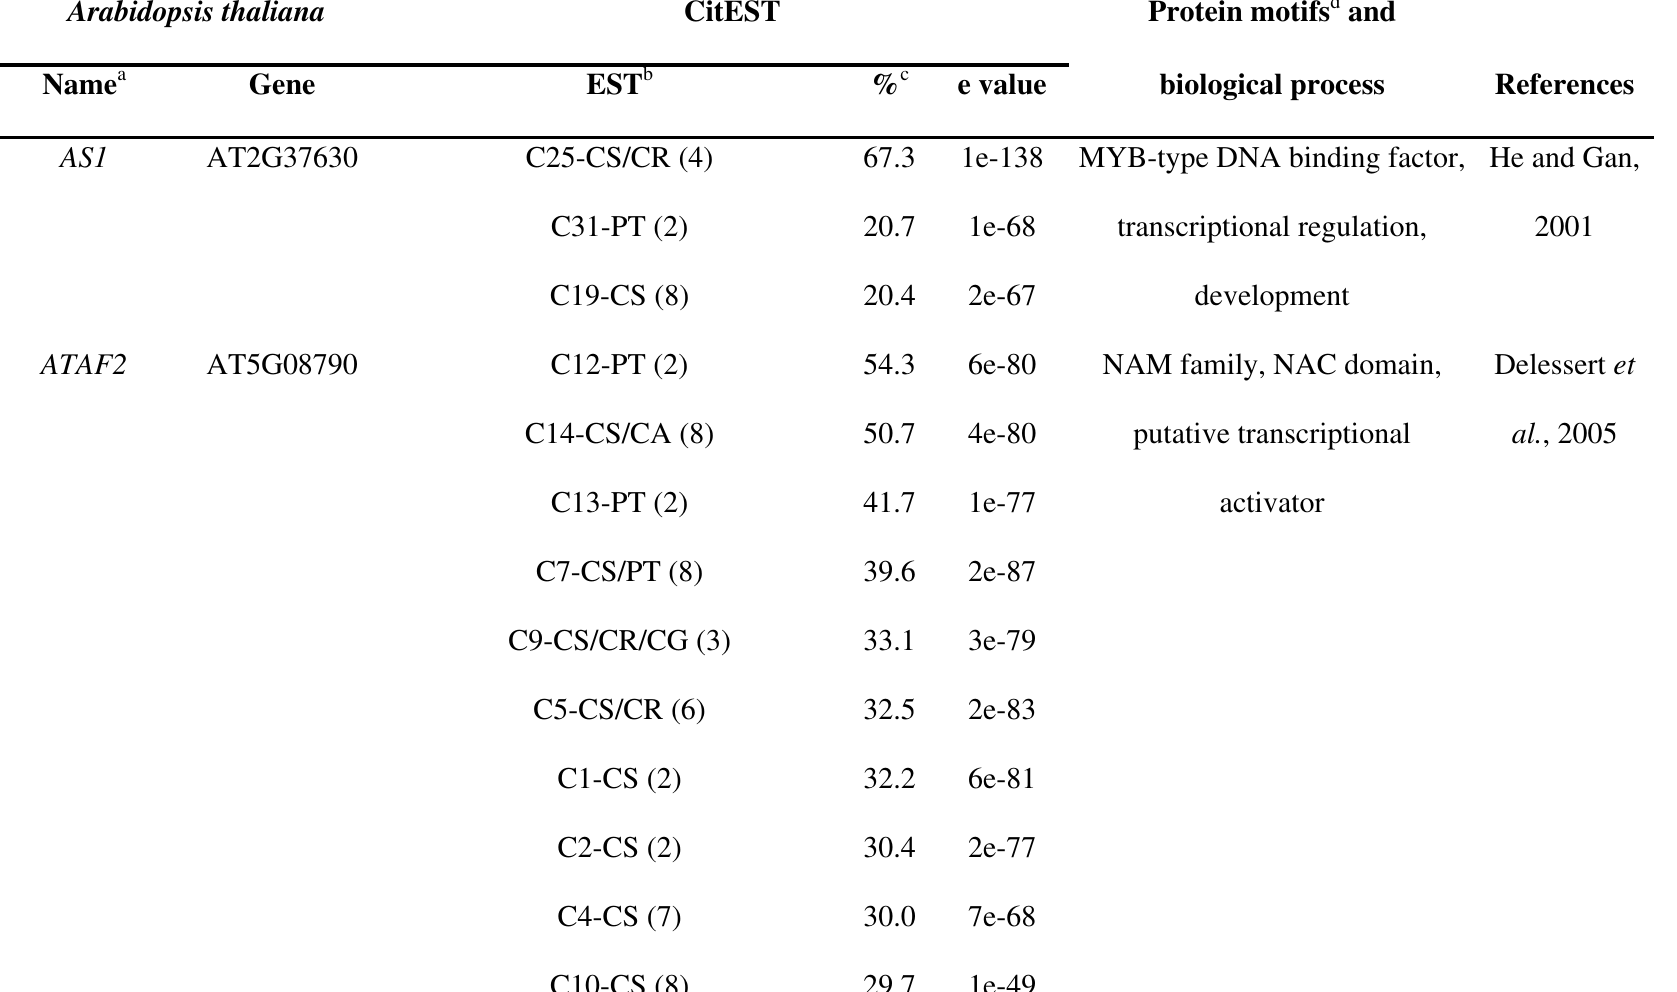
Table S12 – Citrus ESTs with homology to genes involved in jasmonic acid-mediated signal transduction in Arabidopsis thaliana . Arabidopsis